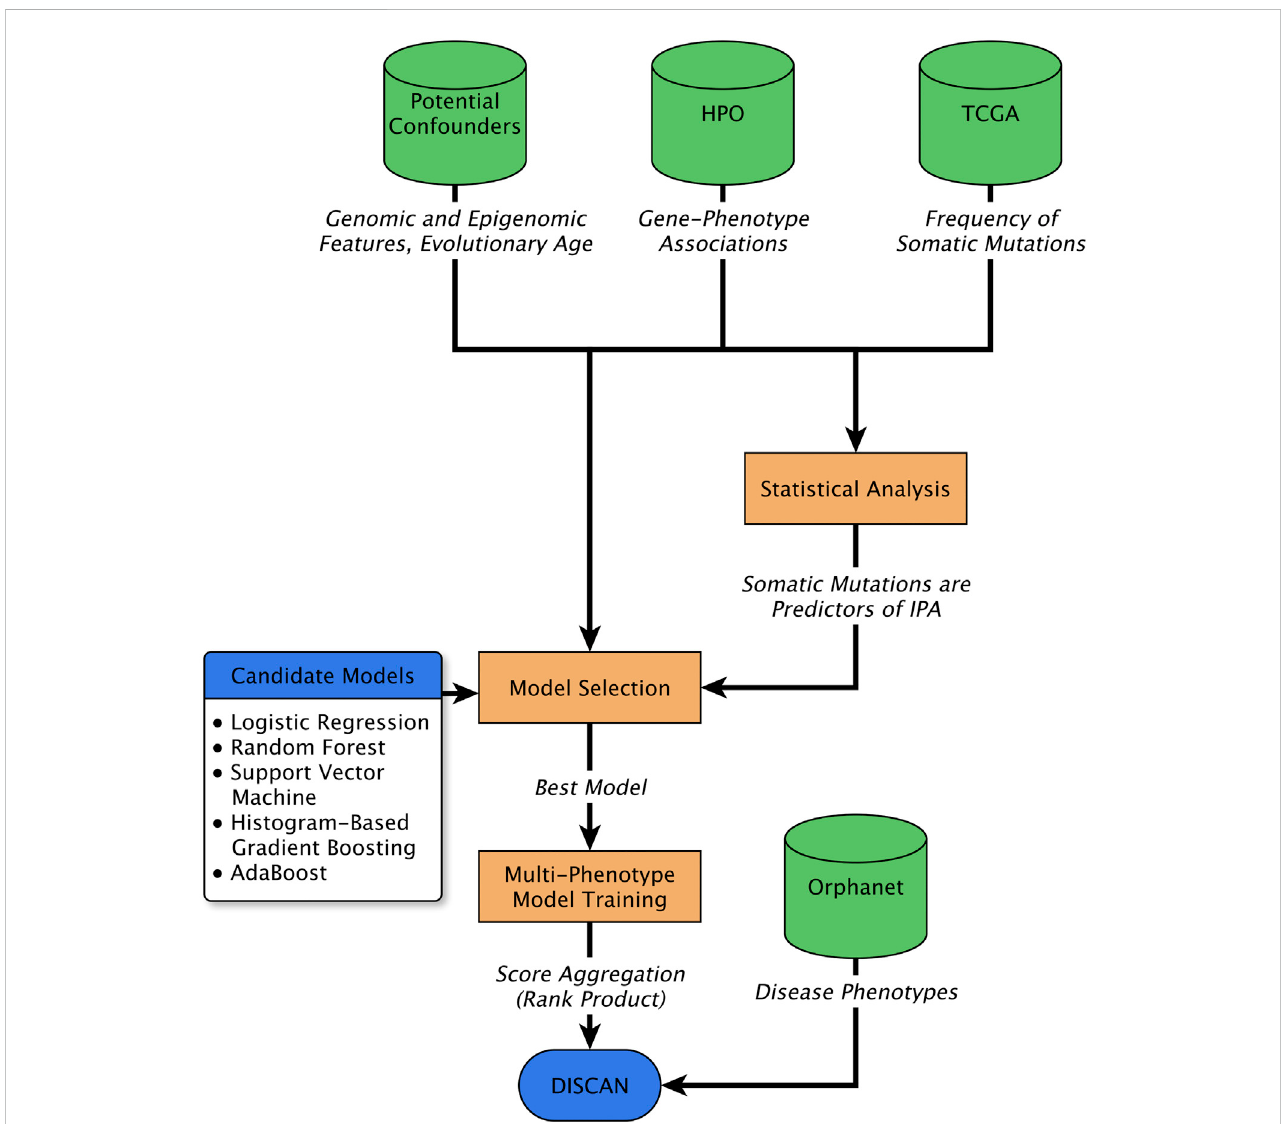
FIGURE 1 Schematic representation of the procedure adopted in this work. The total number of somatic mutations (TSM) pro fi led in large cancer datasets (TCGA) were used, together with gene-phenotype associations obtained from the Human Phenotype Ontology (HPO), and several potential confounders of their association, including gene evolutionary age, genomic factors and epigenomic features. Statistical analysis (multivariable logistic regression) was used to establish TSM as signi fi cant and independentpredictor of genes involvedin abnormal phenotypes (IPA). In addition, several machine learning algorithms were trained to predict IPA from the same set of features. The best performing paradigm was chosen and trained to generate independent predictive models for multiple phenotypes. The predictions for phenotypes associated to any disease were aggregated to perform disease gene prioritization.